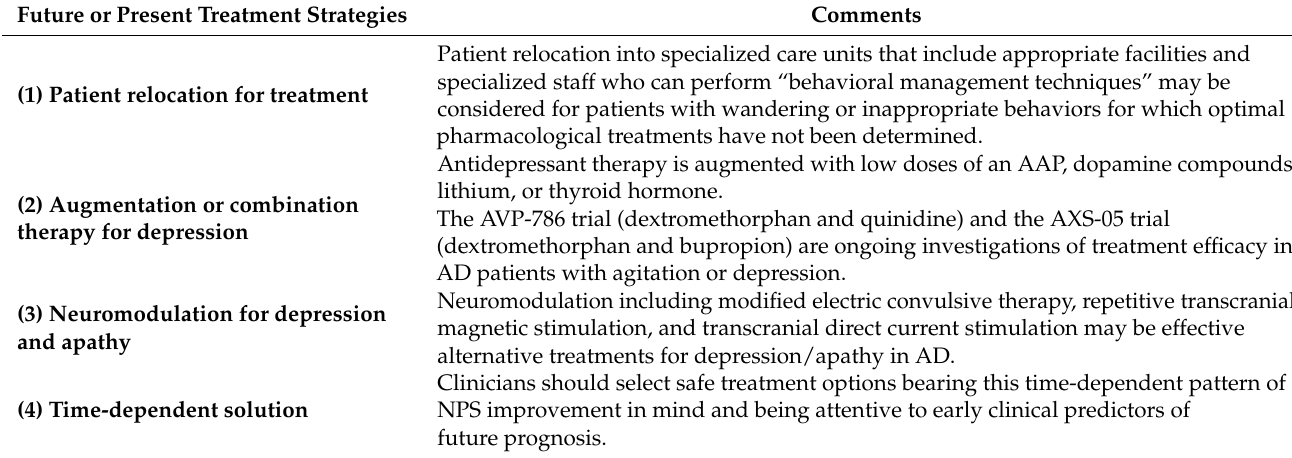
Table 3. Perspectives on treatment strategies for